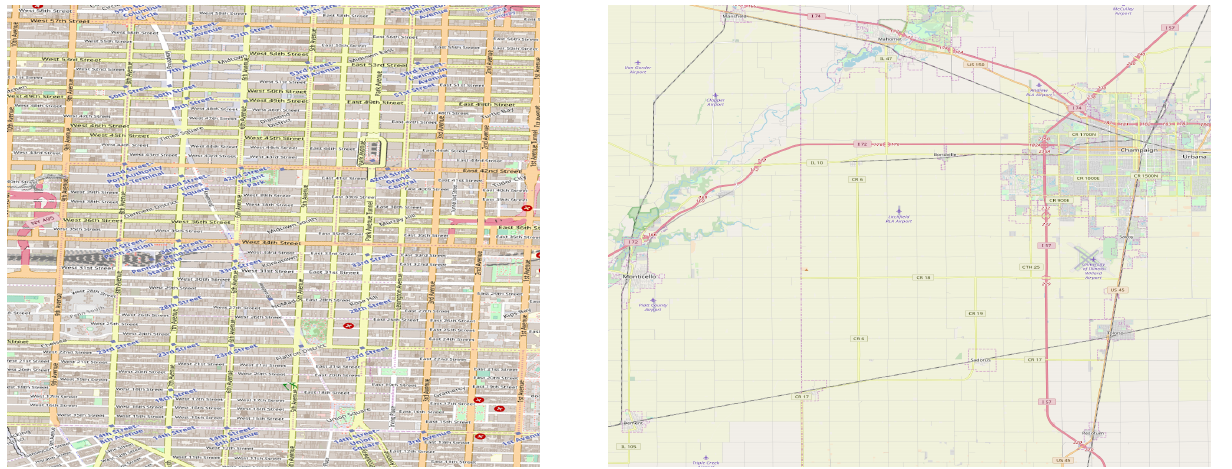
Figure 1. Grid-like substructures in real networks (Manhattan on the left, Urbana-Champaign on the right) (by